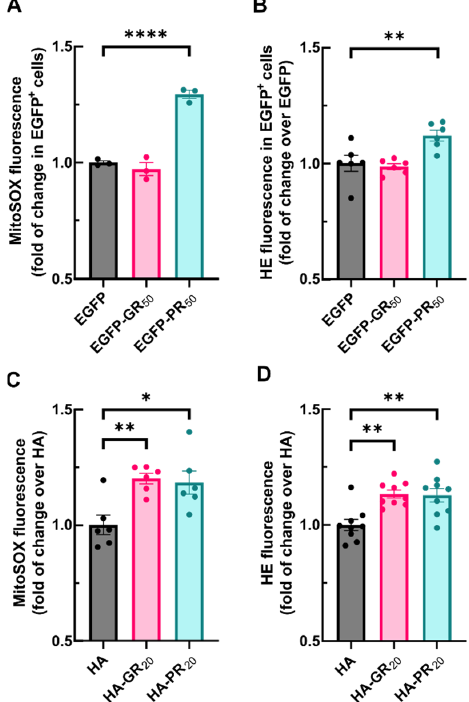
Figure 3. DPRs exposure leads to mitochondrial and intracellular superoxide generation in NSC34 cells. ( A ) NSC34 cells were transiently transfected with EGFP (control), EGFP-GR 50 or EGFP-PR 50 during 48 h. or treated with 6 µ M of HA, HA-GR 20 or HA-PR 20 peptides for 2 h. ( A , C ) Cells were treated with 1 µ M MitoSOX during 30 min and fluorescence was measured by flow cytometry analysis. ( B , D ) cells were treated with 2 µ M hydroethidine during the last hour of transfection/treatment and probe intensity was measured by flow cytometry analysis. Each point depicts the geometric mean of probe fluorescence in cells from that sample (( A , B ), alive/EGFP + cells, ( C , D ), all alive cells). Bar height indicates the mean of the whole group and error bars indicate the SEM. Statistical analysis was performed with one-way ANOVA. Dunnett’s post-hoc test. *, p < 0.05; **, p < 0.01; ****, p <